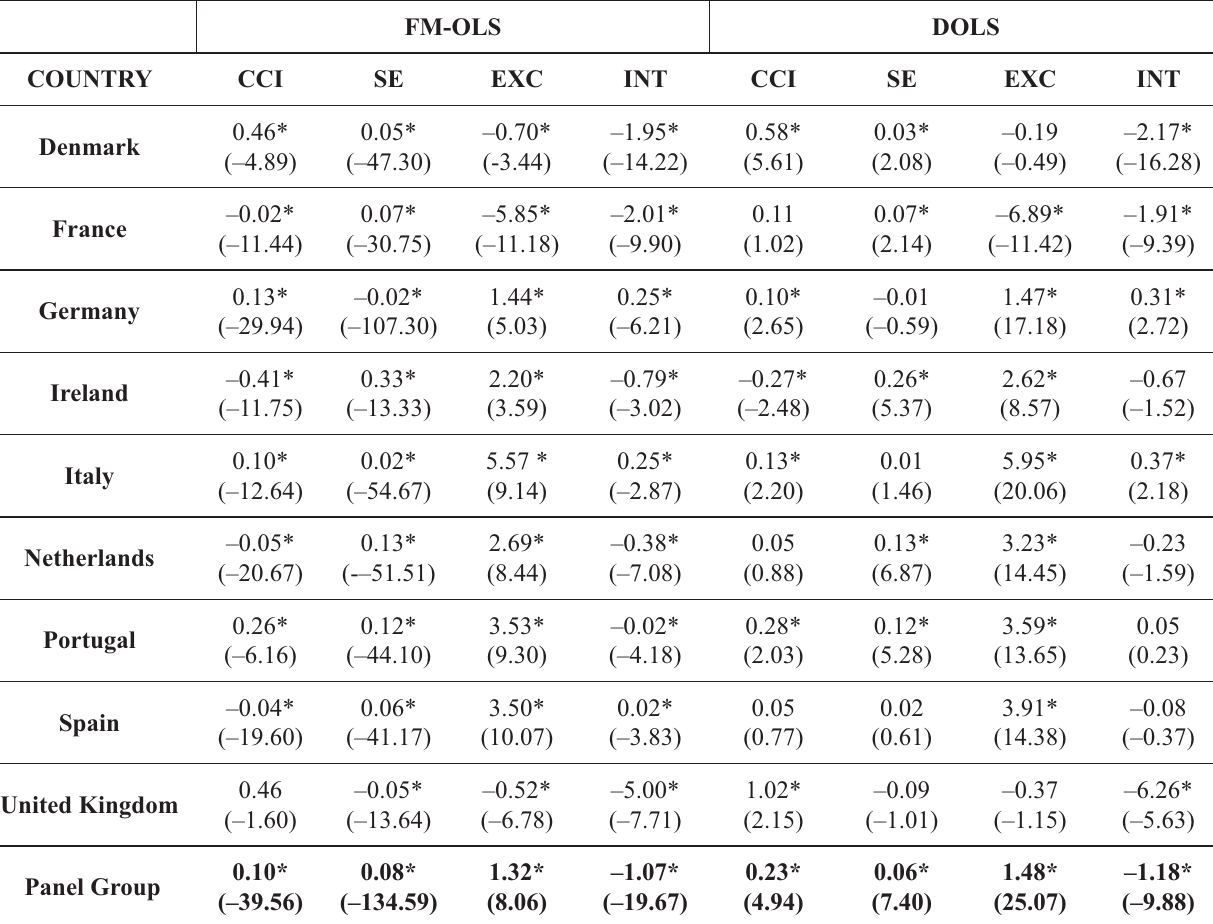
Table 3. FM-OLS and DOLS Tests for Coeffi cient